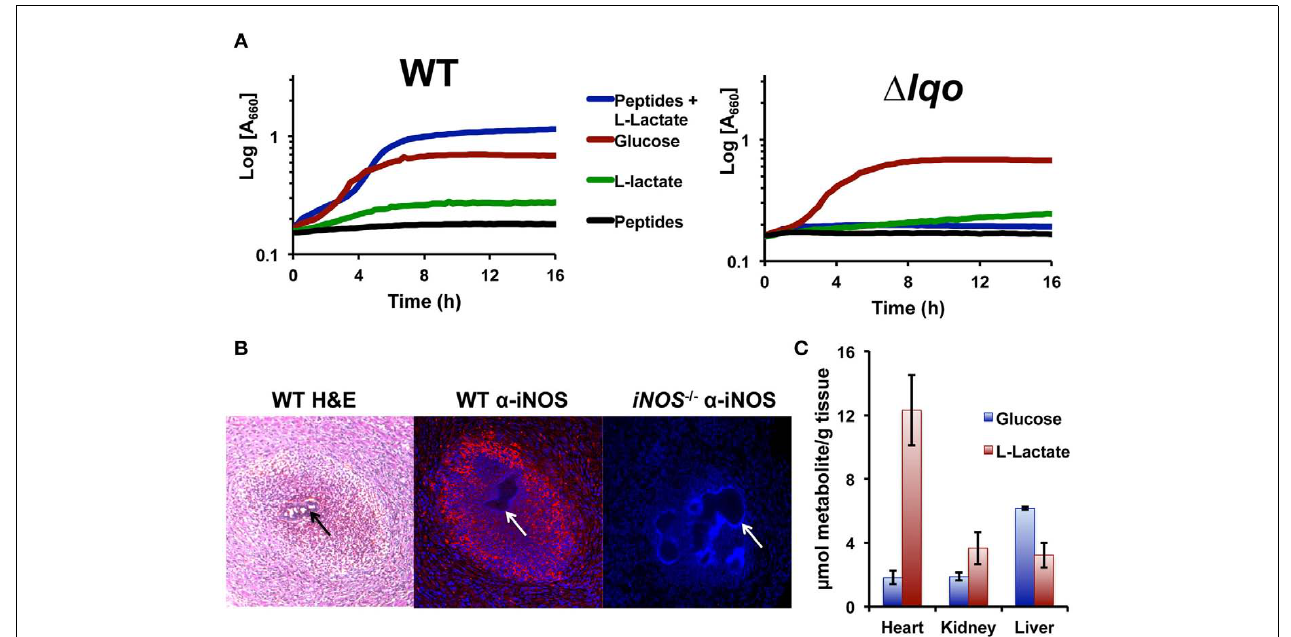
surrounded by infiltrating granulocytic cells. Center, immuno-histofluorescent staining of the same abscess with anti-iNOS monoclonal Ab reveals robust iNOS expression throughout the abscess. Tissue was counter-stained with DAPI to reveal host cell nuclei. Non-staining S. aureus microcolony is visible (white arrow). Right, identical immuno-histofluorescent staining of a similar abscess in an iNOS − / − mouse as a negative control for anti-iNOS Ab.Tissue was also counter-stained with DAPI. (C) Metabolite data from murine tissues were determined using enzymatic methods previously described and normalized to total organ